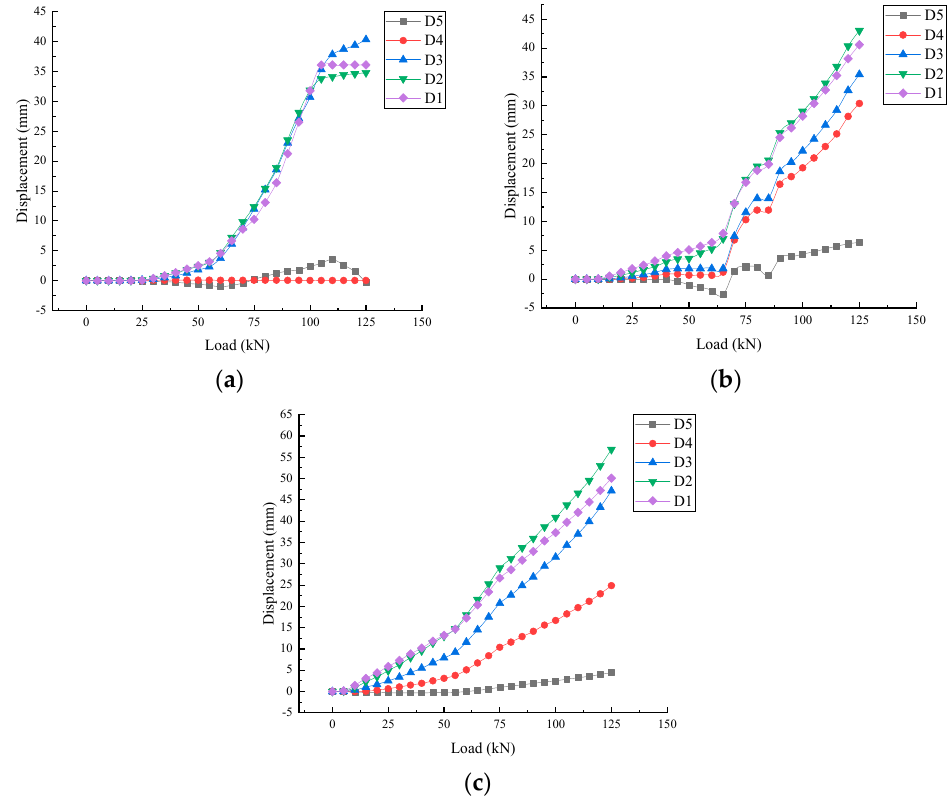
Figure 7. Variation of horizontal displacement in the slope with a slope top load. ( a ) Test G1 plain soil slope. ( b ) Test G2 bamboo-rooted slope. ( c ) Test G3 rainfall bamboo-rooted slope.